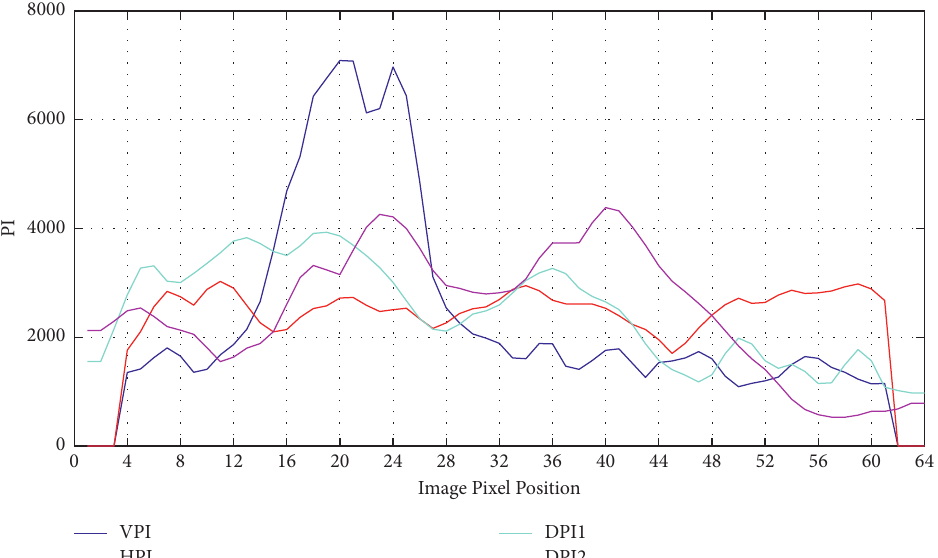
Figure 10: Illustration of the computed projection integrals.